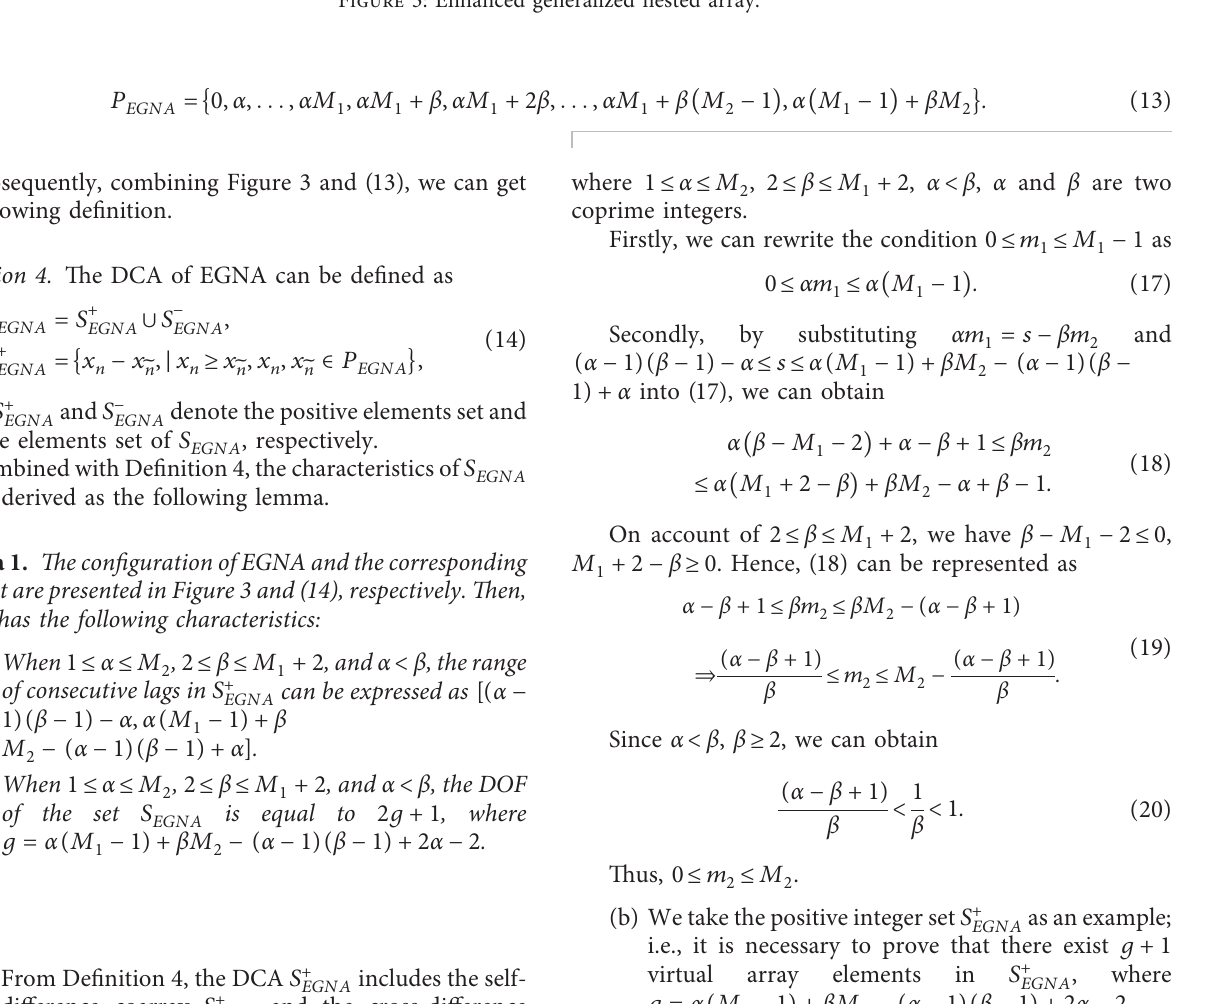
Figure 3: Enhanced generalized nested